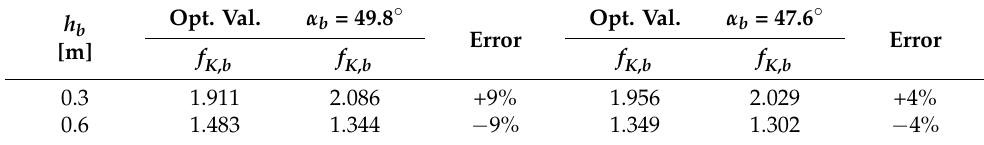
Table 4. Optimized value of α b , f K , b [m] and respective error, optimum values from Table 2. Opt. Val. α b = 49.8 ◦ h b [m]